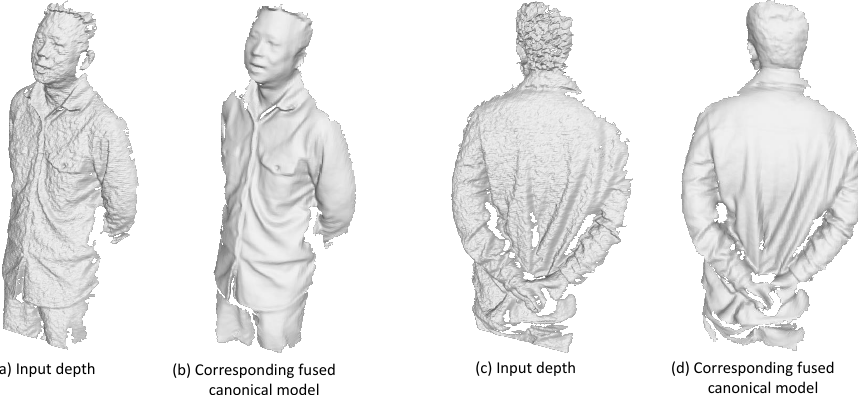
Figure 3. Some sampled partial pieces generated from the fusion procedure. ( a , c ) are some input frames; ( b , d ) are corresponding partial